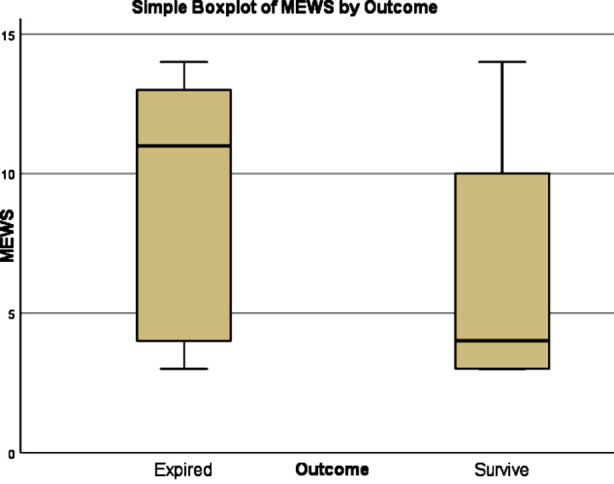
Box plot of MEWS Score with Outcome.